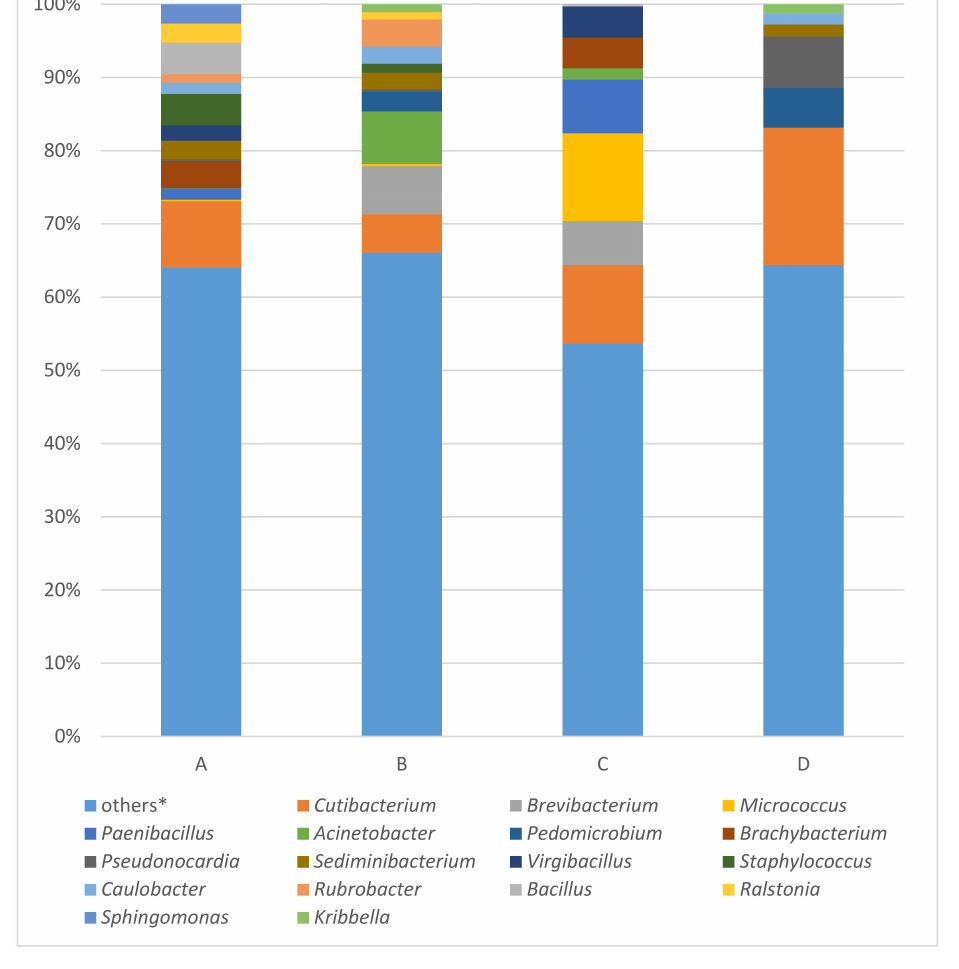
Figure 3. Results of bacterial 16S rRNA gene analysis of samples A (the ribbon of the bodice), B (body of the bodice), C (tissue covering the sti ff reinforcement of the bodice), D (silk bobbin lace cap) using MinION. * Others: the percentages of reads assigned to taxa under (below) the value of 2% in the sum of all four